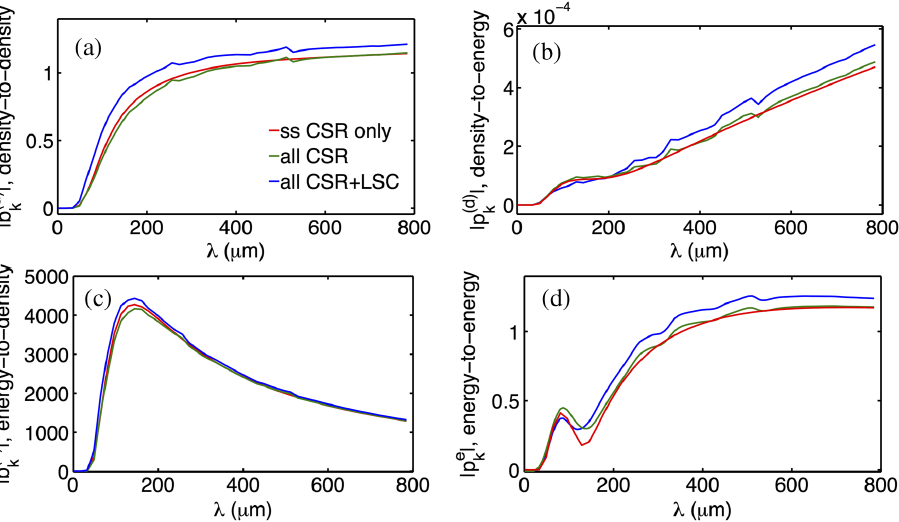
FIG. 7. Microbunching gain spectra for (a) density-to-density; (b) density-to-energy; (c) energy-to-density; and (d) energy-to-energy modulation. Note that in the figures the resultant modulations are evaluated in units of initial modulations.